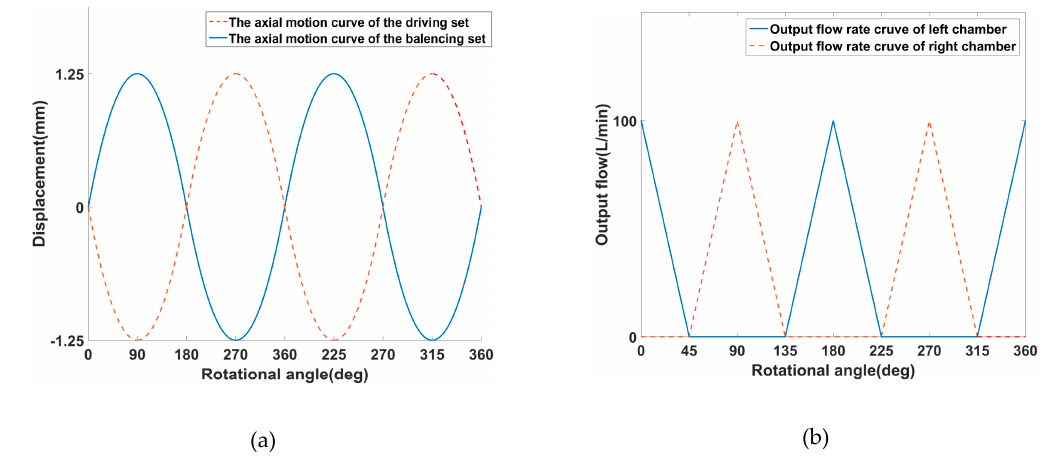
Figure 4. Theoretical curves of the high-speed 2D piston pump [17]. ( a ) The curves of the reciprocating motions; ( b ) the curves of the output flow rates.